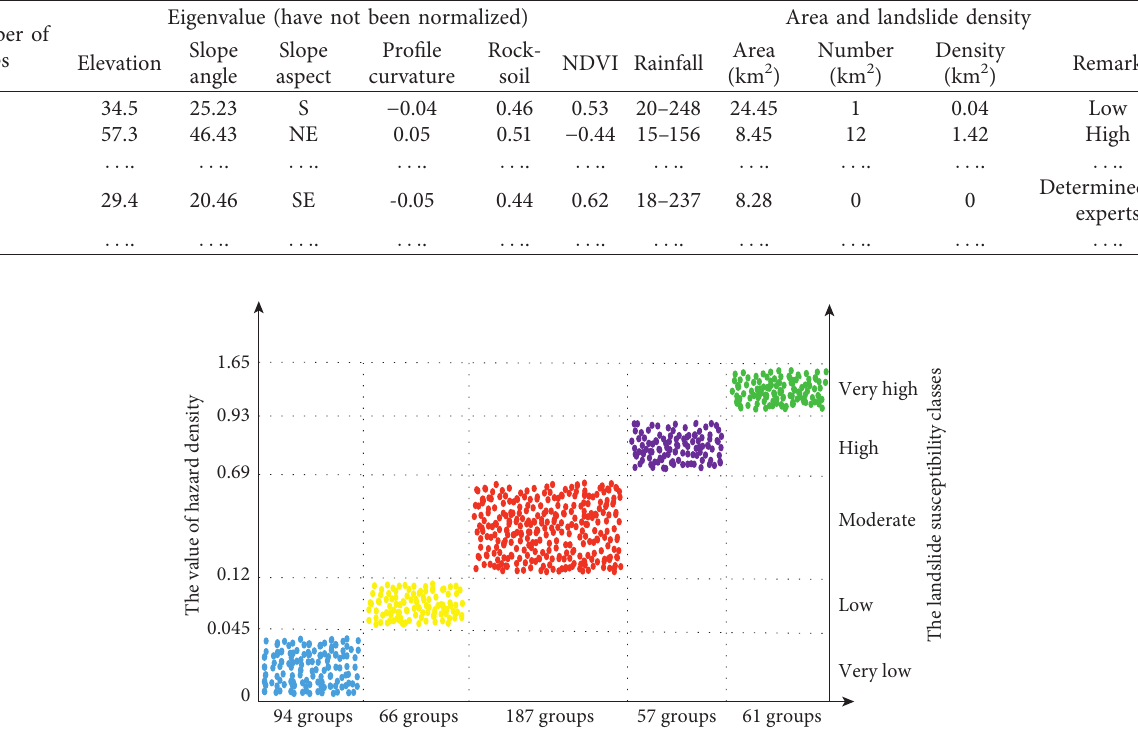
Figure 8: The landslide susceptibility classes of all groups.